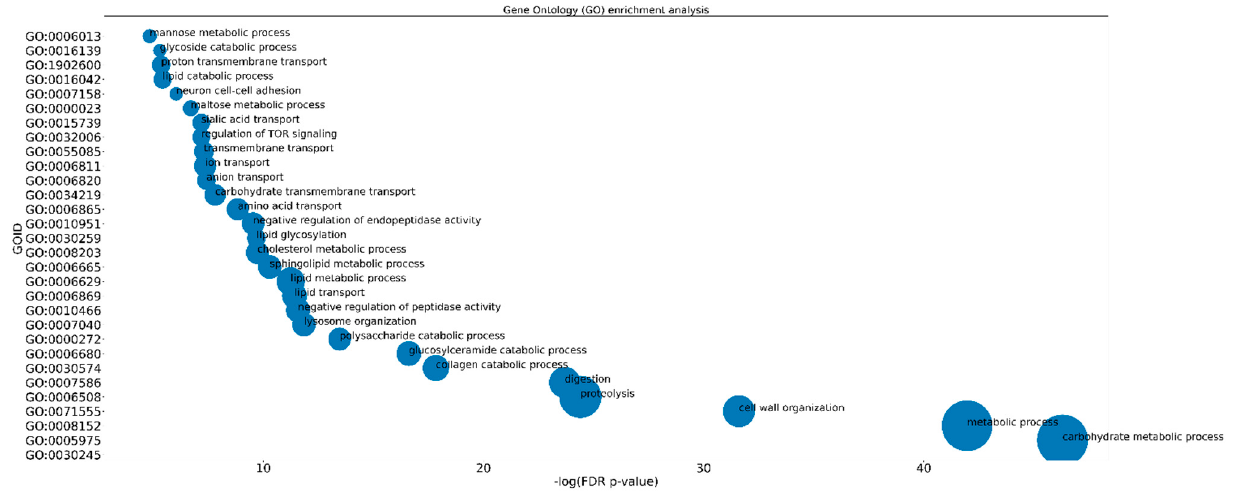
Figure 5. Scatterplot for significantly enriched Biological Process GO IDs against log10-transformed FDR-corrected p -values. Dot size is proportional to the number of DEGs mapping to that GO term. The reliability of statistical estimates increases from left to right along the x -axis.